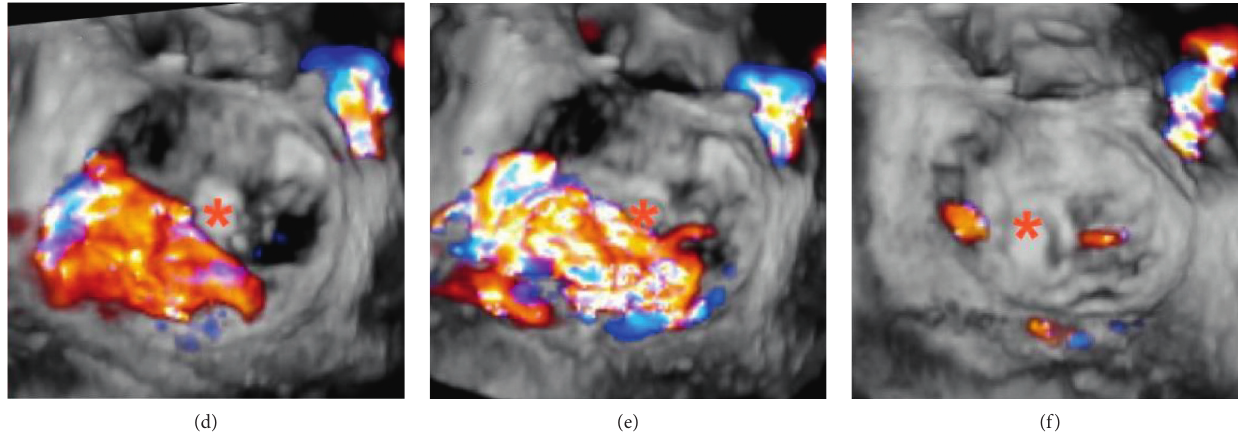
Figure 6: 3D CFD TEE assessment Patient A: (a) 3D TEE image with CFD showing a prolapse P2 segment (arrowheads) with a single wide central jet and (b) after implantation of 1 clamp, trivial residual mitral regurgitation is visible. Patient B: (c), (e), (f) in a case of noncentral bileaflet prolapse, prerelease 3D CFD TEE (d): early systolic frame, E: mid systolic frame) revealed a significant lateral residual MR following a central implantation of 1 clamp (c: white dotted line); after adjustment of position and regrasping of leaflets (c: green dotted line), two trivial residual MR jets are visible (f). This case highlighted the importance of precise clamp deployment for the maximal reduction of MR. Asterisks indicate